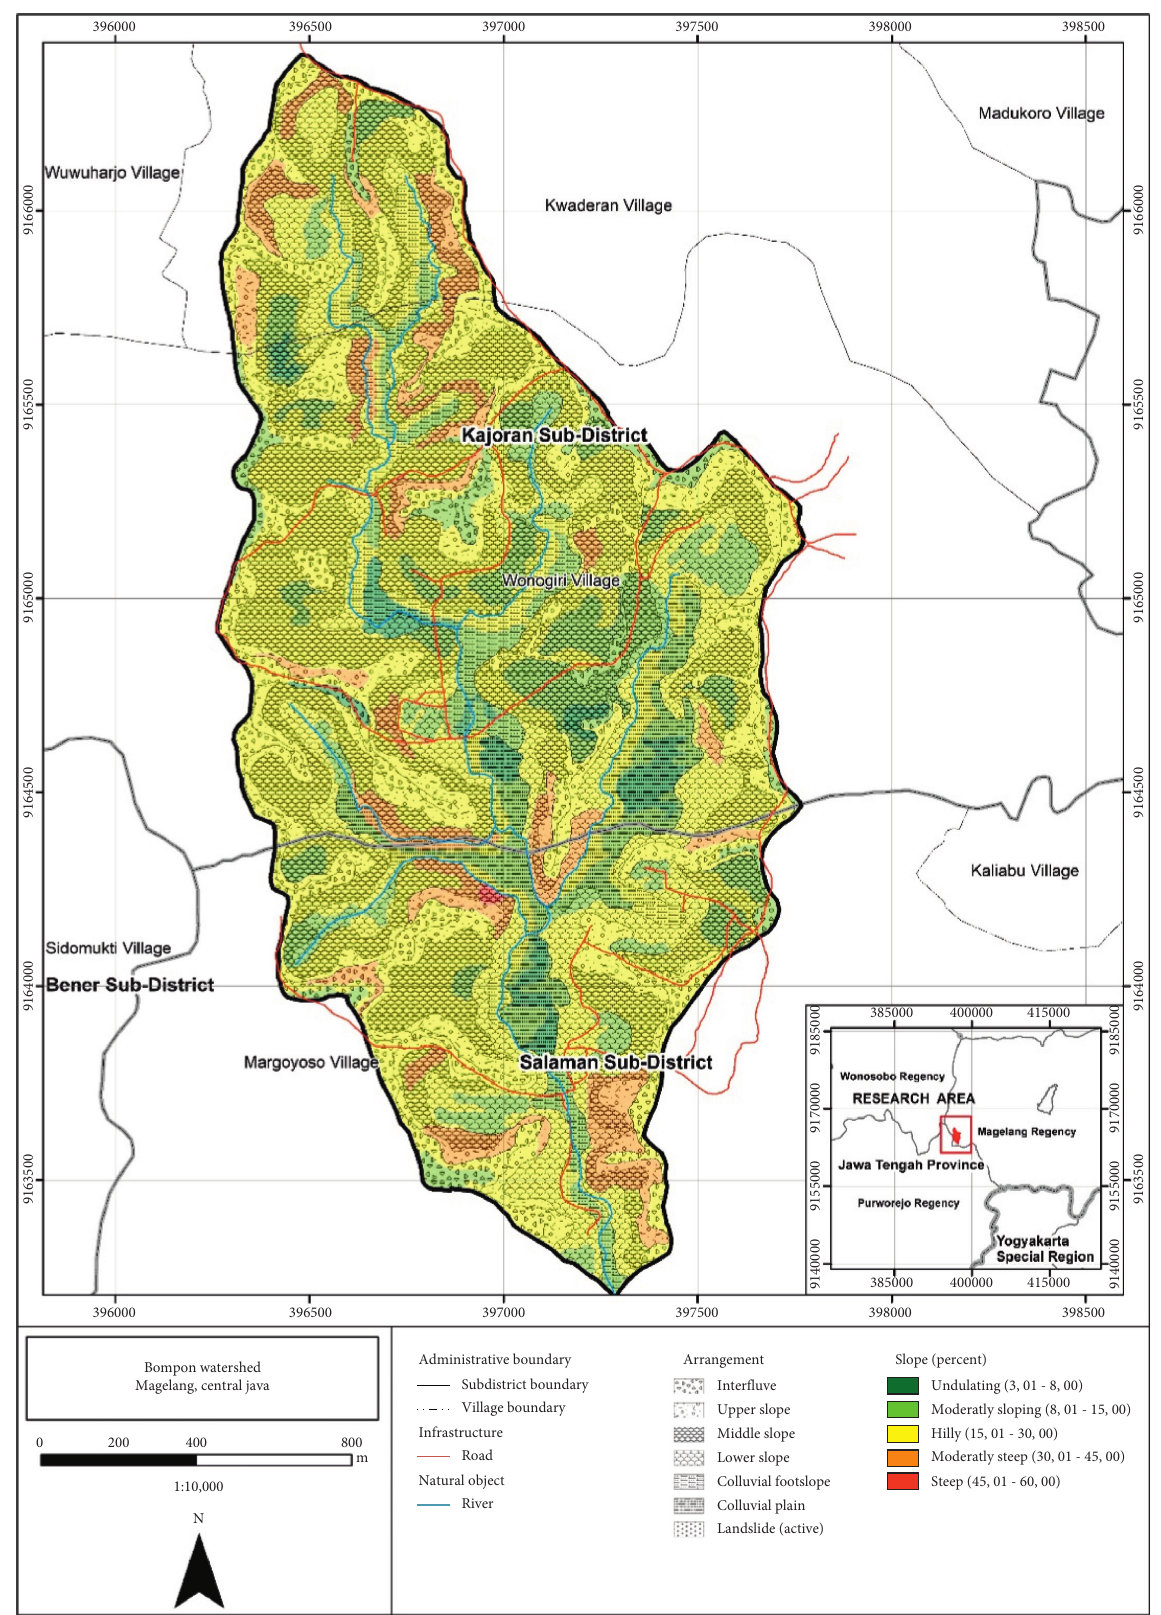
Figure 4: Geomorphometry map of Bompon watershed. There are seven classes of the arrangement and five classes of the slope. There is no flat area shown on the map because the proportion is too small and should be generalized. The dominant slope is Hilly, while the middle slope is the dominant